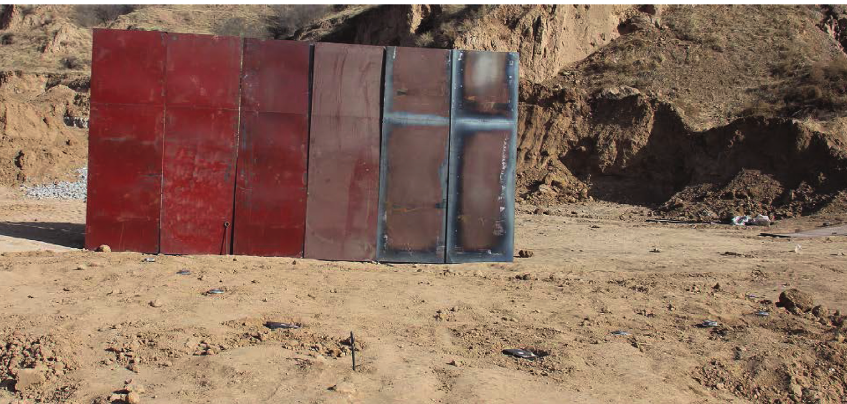
Figure 3: Dynamic explosion test layout of shock wave overpressure. Table 1: Testing radius and device number of the first projectile.